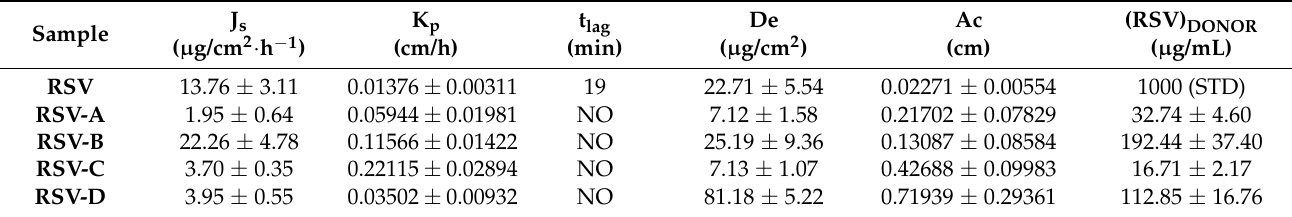
Figure 4. ( A ) RSV permeation profiles: RSV (mg/cm 2 ) permeated as a function of incubation time (h). ( B ) Kp and ( C ) Ac parameters, calculated after administration of RSV solution 1 mg/mL (black), RSV-A mini-tablet (blue), RSV-B mini-tablet (red), RSV-C mini-tablet (green) and RSV-D mini-tablet (pink). Results are presented as means ± SE ( n = 6). Table 6. Extrapolated RSV biopharmaceutical parameters (Js, Kp, t lag , De and Ac ± SE) and RSV concentration in the donor chamber after mini-tablets ex vivo